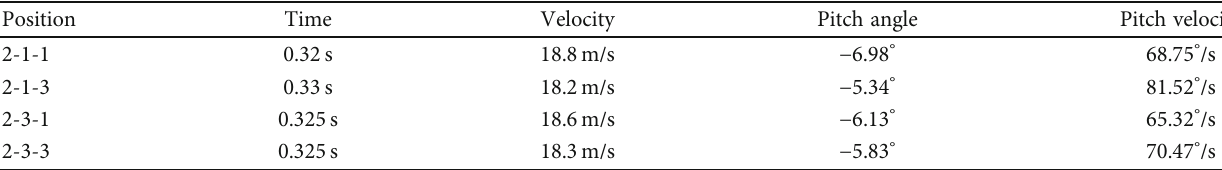
Table 3: The results from di ff erent loading